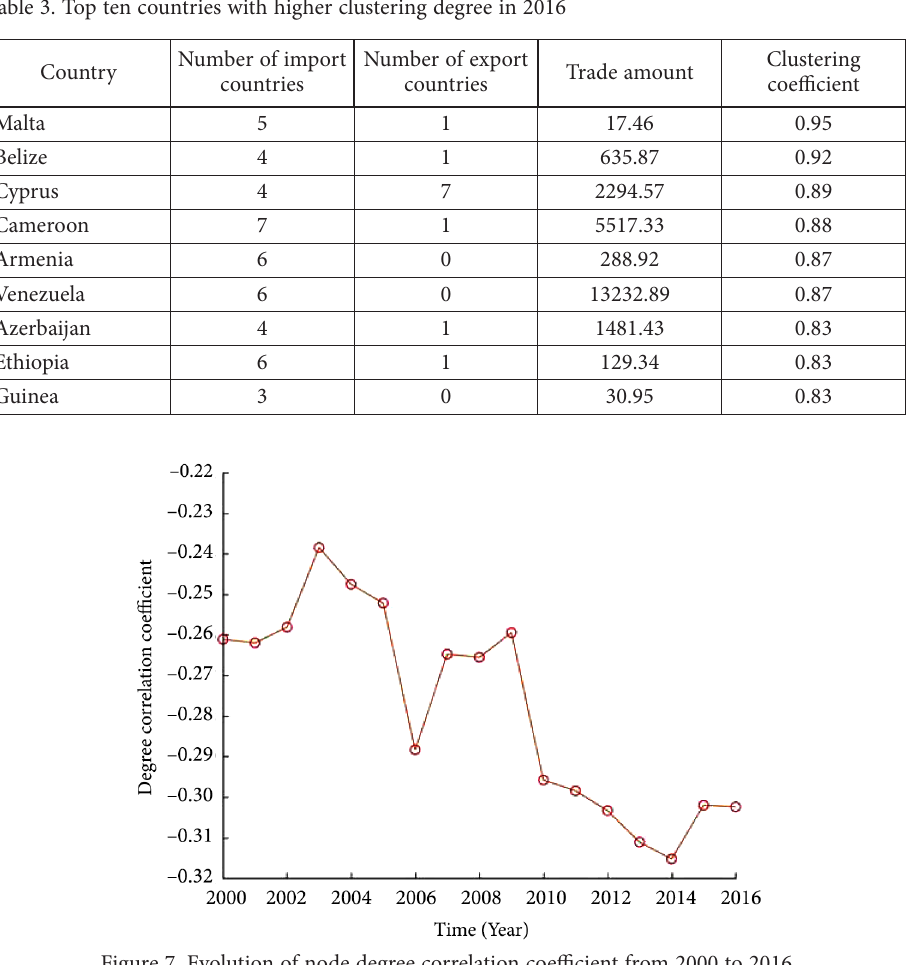
Figure 7. Evolution of node degree correlation coefficient from 2000